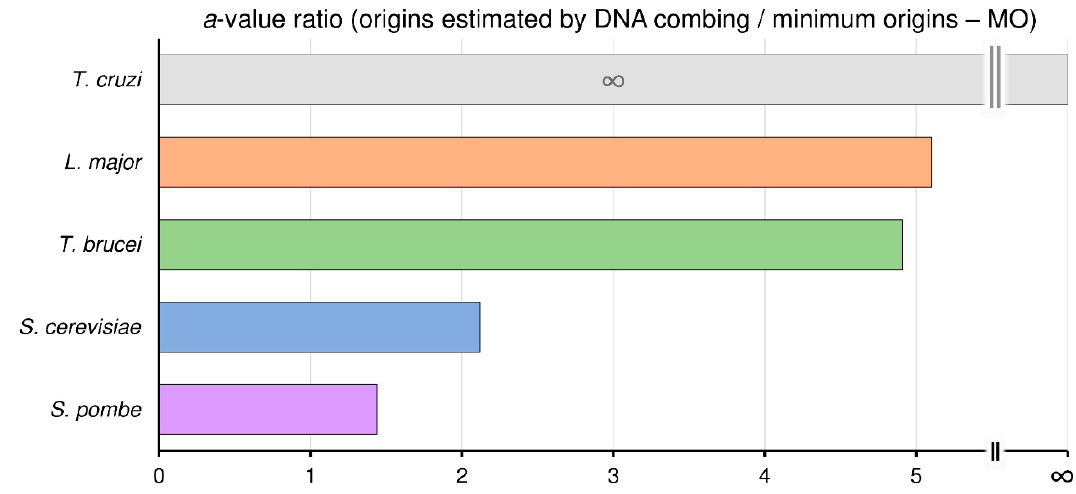
Figure 3. Trypanosomatids use around fivefold more origins than the minimum required. Angular coefficient (a-value) ratios between origins estimated by DNA combing and the minimum origins (MO) for T. cruzi (gray bar), L. major (orange bar), T. brucei (green bar), S. cerevisiae (blue bar), and S. pombe (purple bar).